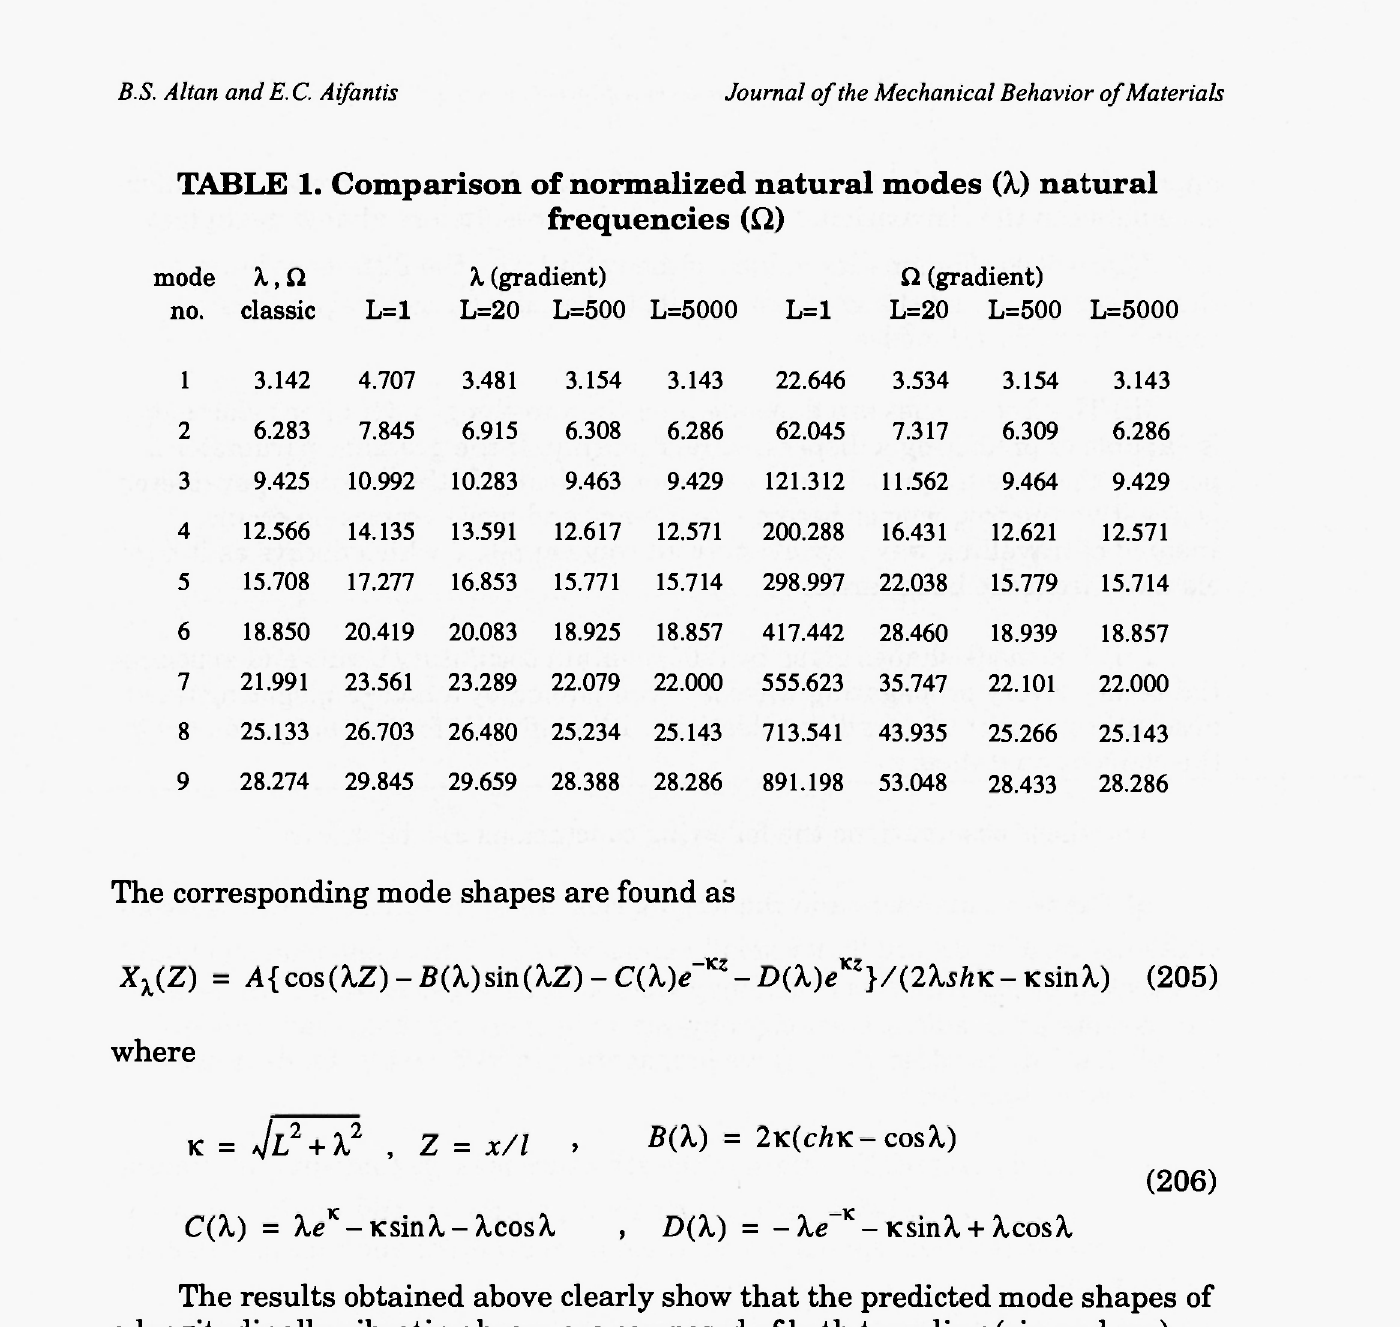
TABLE 1. Comparison of normalized natural modes (λ) natural frequencies